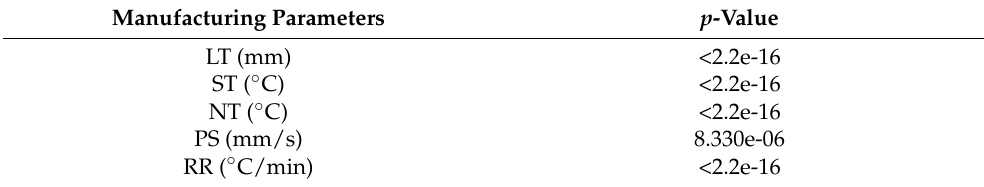
Table 3. ANOVA analysis